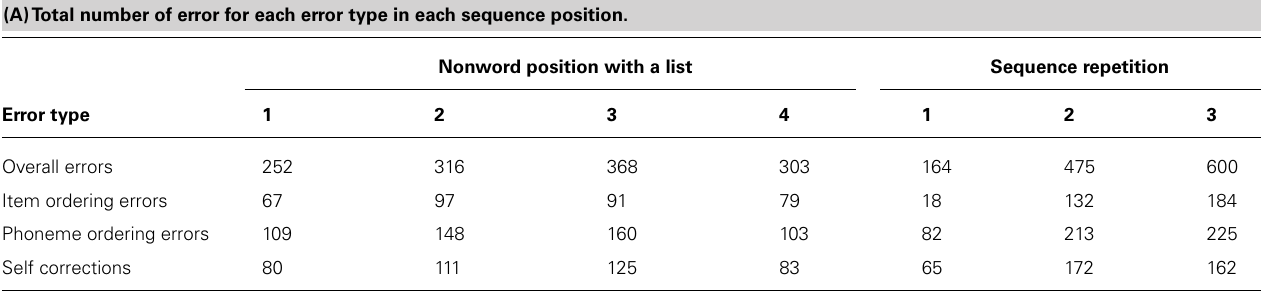
nonwords in a sequence, of errors as a function of sequence repeti- tion ( Table 2A ) and the distribution of speech sound errors across Table 2 | Distribution of errors across different sequence positions and nonword positions. (A)Total number of error for each error type in each sequence